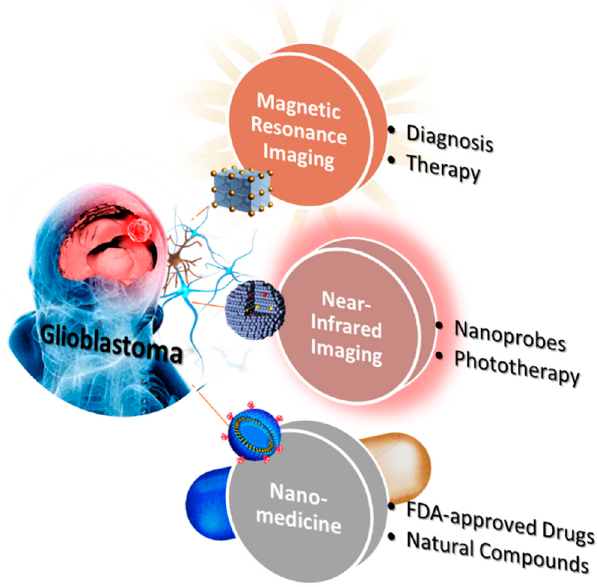
Figure 1. The three primary goals of research into GBM. The current research focuses on the long-term magnetic and near-infrared diagnosis and natural and chemical drugs equipped with nano-materials.